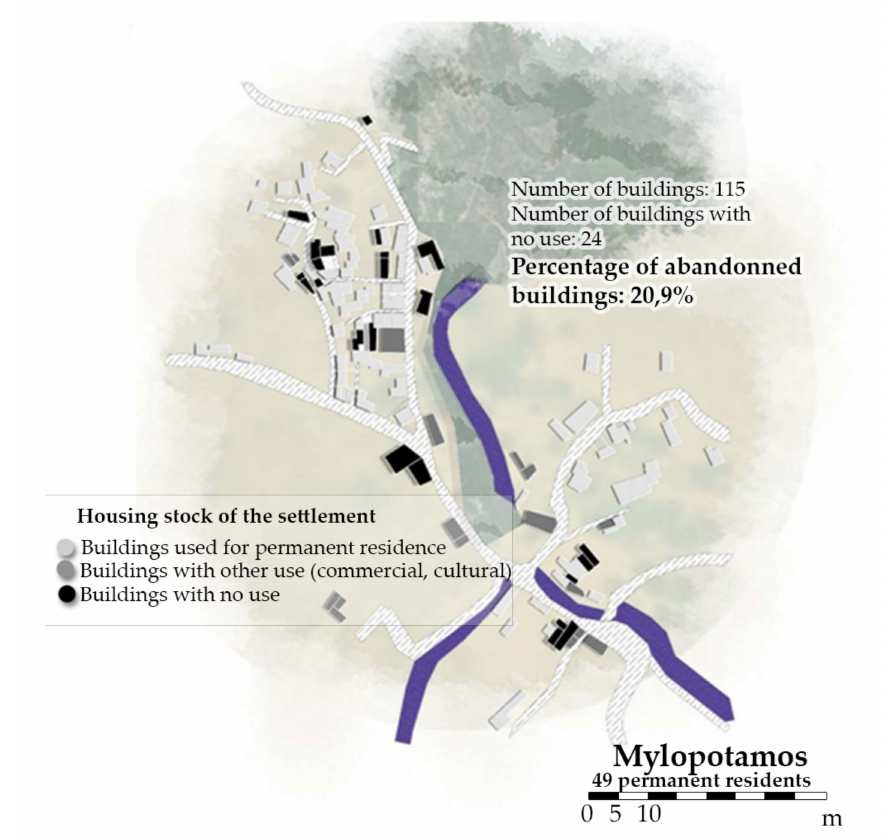
Figure 23. The housing stock of